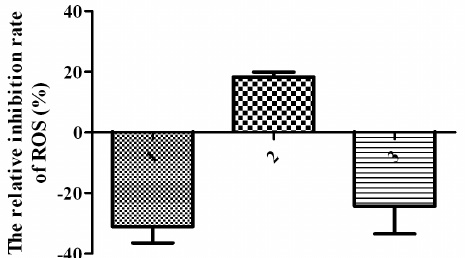
SeO treatment. ( 1 ) pSelExpress1- GFP-SelM ; 2 3 SeO ; ( 3 ) Cells transfected 2 3